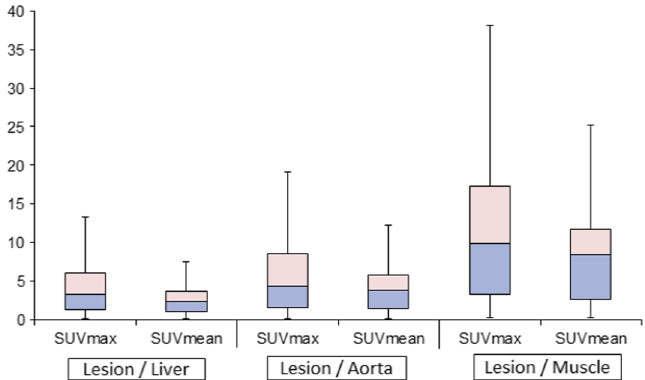
Fig. 2 The lesion SUV normalization to different background areas including liver, aorta, and muscle using SUVmax and SUVmean